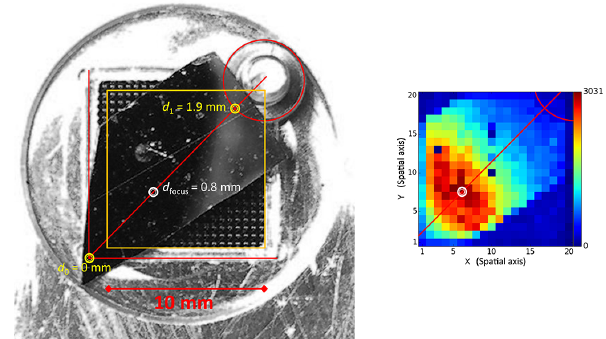
Figure 8. A tilted silicon piece is put in front of the sample-side MLA of AO2 (left). The distant-dependent distribution of the sili- con’s Raman signal is plotted in pseudo colors (right). Triangula- tion yields an optimal sample distance d focus = 0 . 8mm, showing the highest Raman